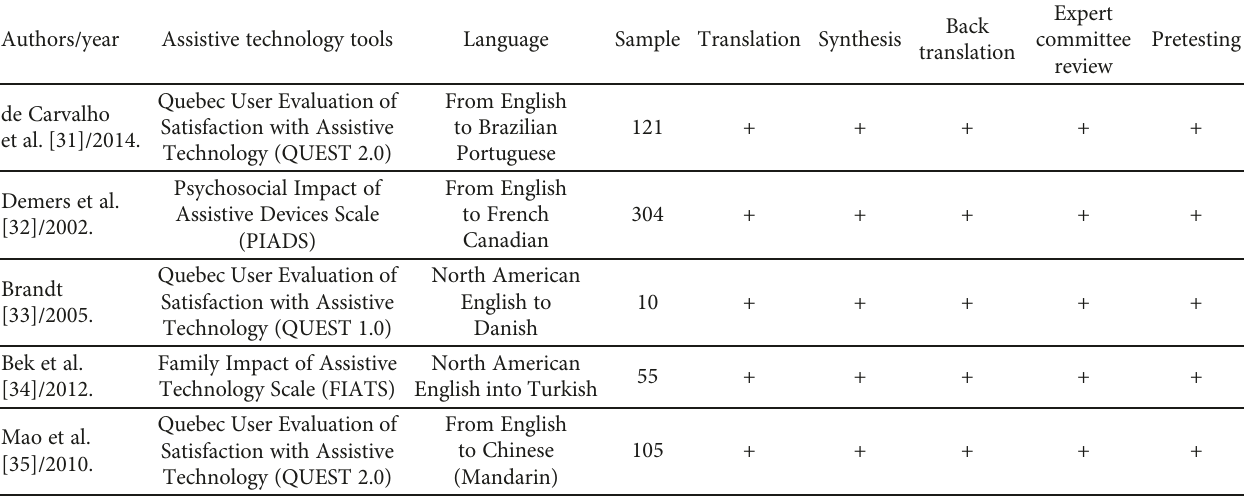
Table 1: Translation and cross-cultural adaptations [4, 6, 10,